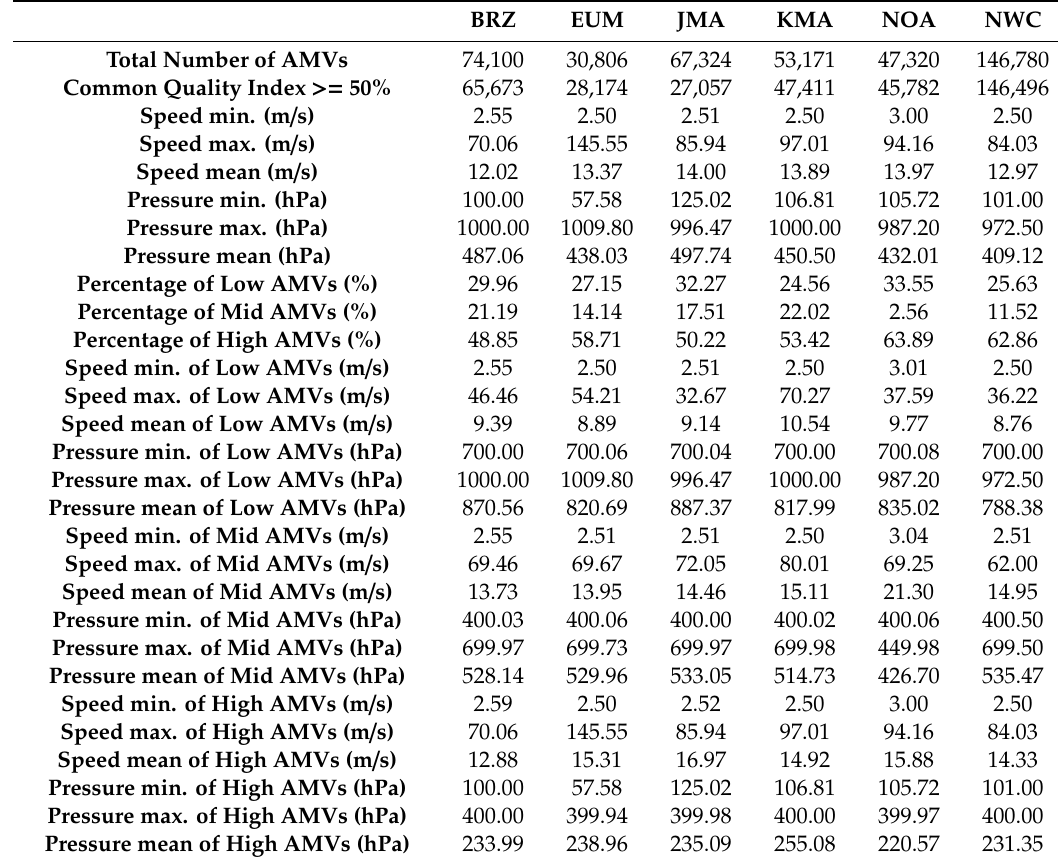
Table 10. Parameter distribution for the di ff erent AMV datasets in experiment 2 with CQI >=